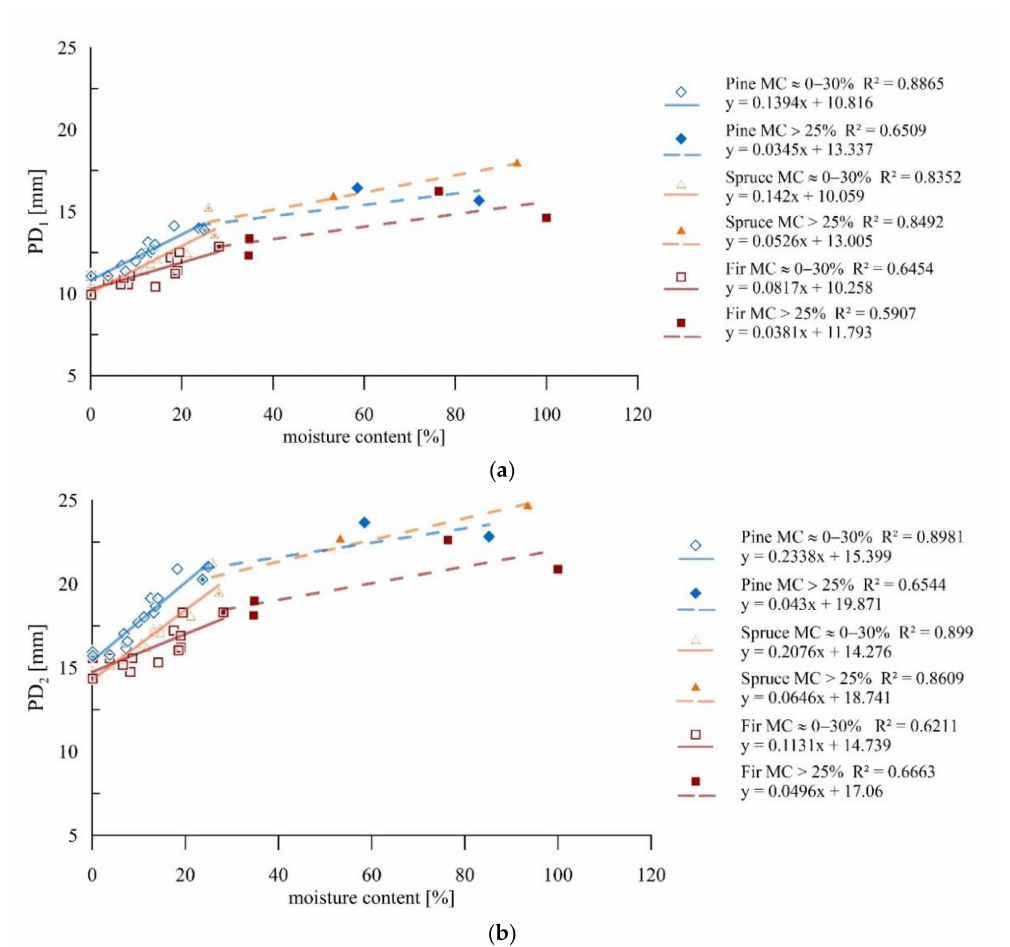
Figure 11. Sclerometric studies on samples of different moisture contents: ( a ) Results for individual wood species for a single impact; ( b ) Results for individual wood species for a double impact.